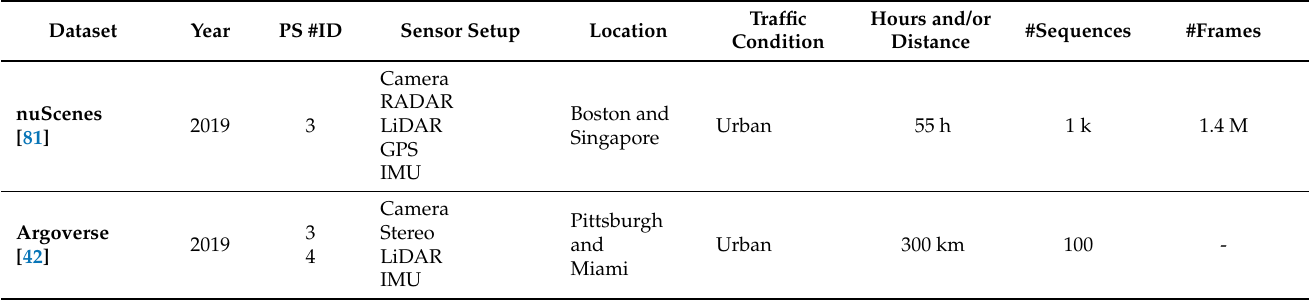
Table 1. Summary of recent RBA datasets. From 1 to 6, the PS (Problem Space) ID refers to